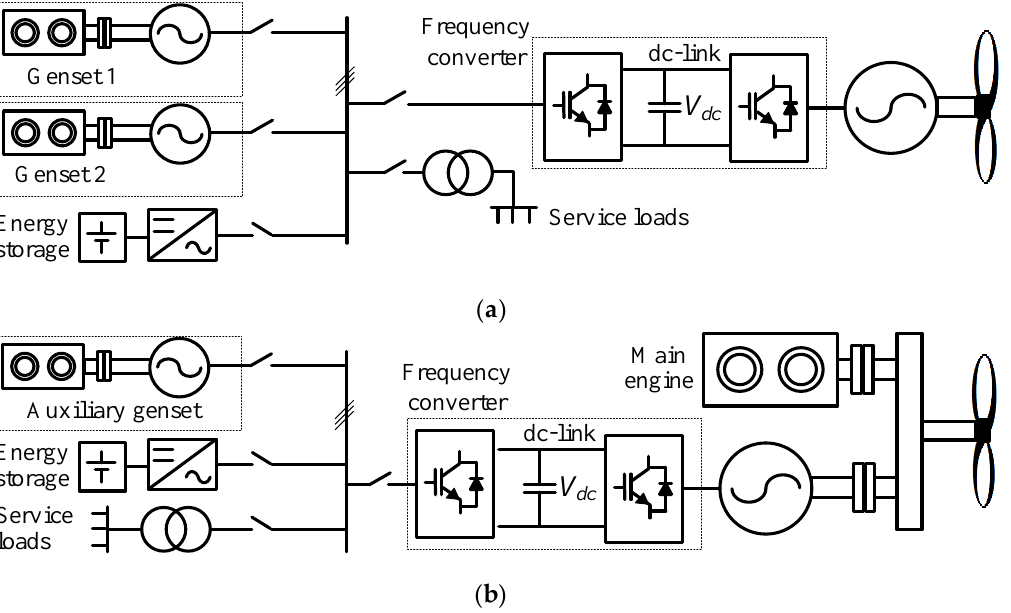
Figure 2. ( a ) Series hybrid ship architecture; ( b ) Parallel hybrid ship architecture.